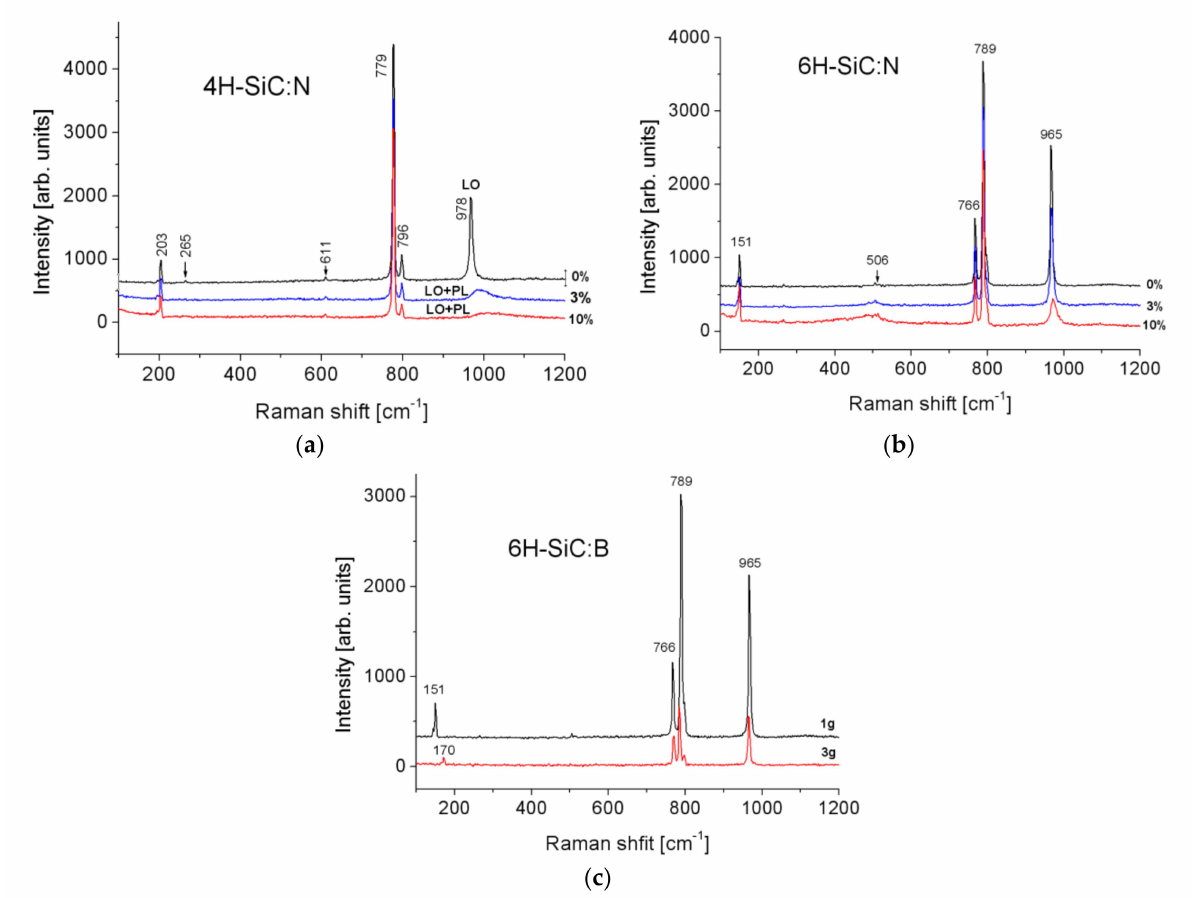
Figure 11. The Raman spectra of N-doped 4H-SiC ( a ) and 6H-SiC ( b ) samples and for B doped 6H-SiC sample ( c